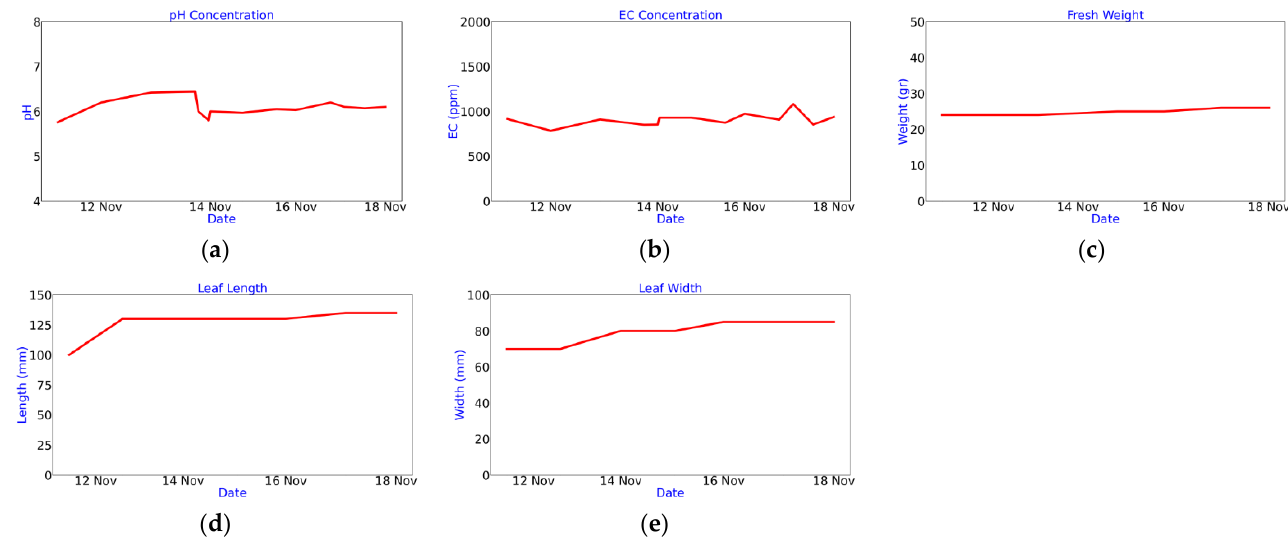
Figure 8. Manual register of variables in nutrient solution and crop. ( a ) pH; ( b ) EC; ( c ) fresh weight; ( d ) leaf length; ( e ) leaf width.